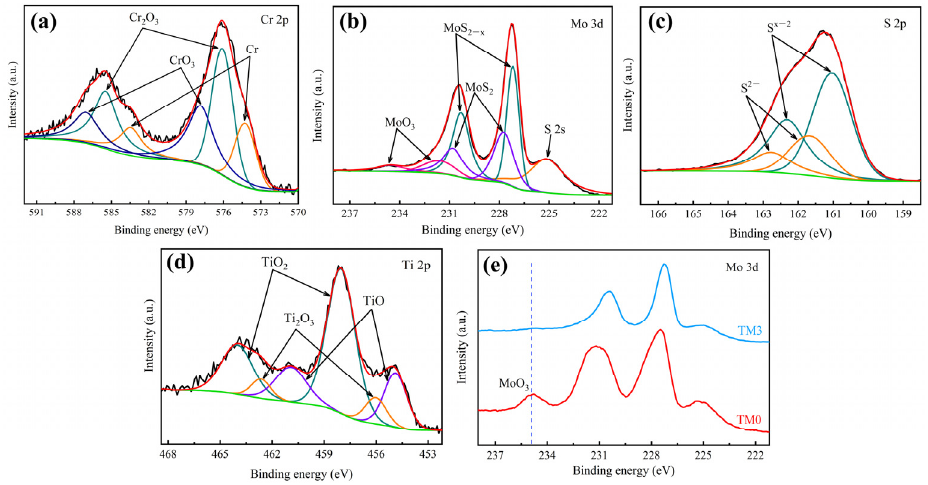
Figure 7. XPS spectra. ( a ) Cr 2p, ( b ) Mo3d, ( c ) S 2p and ( d ) Ti 2p peaks of TM3 coating. ( e ) Mo 3d peak of TM0 and TM3 coatings.